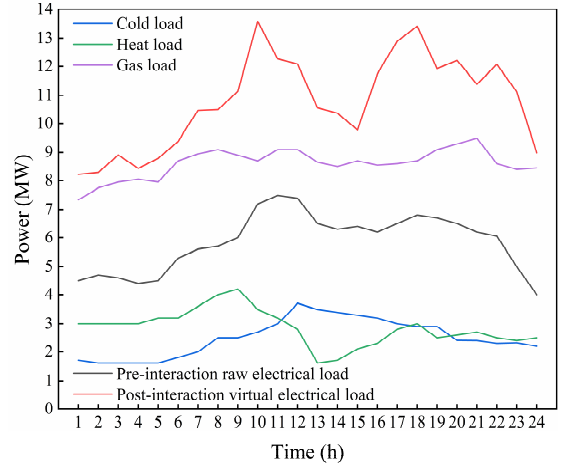
Figure 12. PIES 1 load demand diagram before and after interaction.